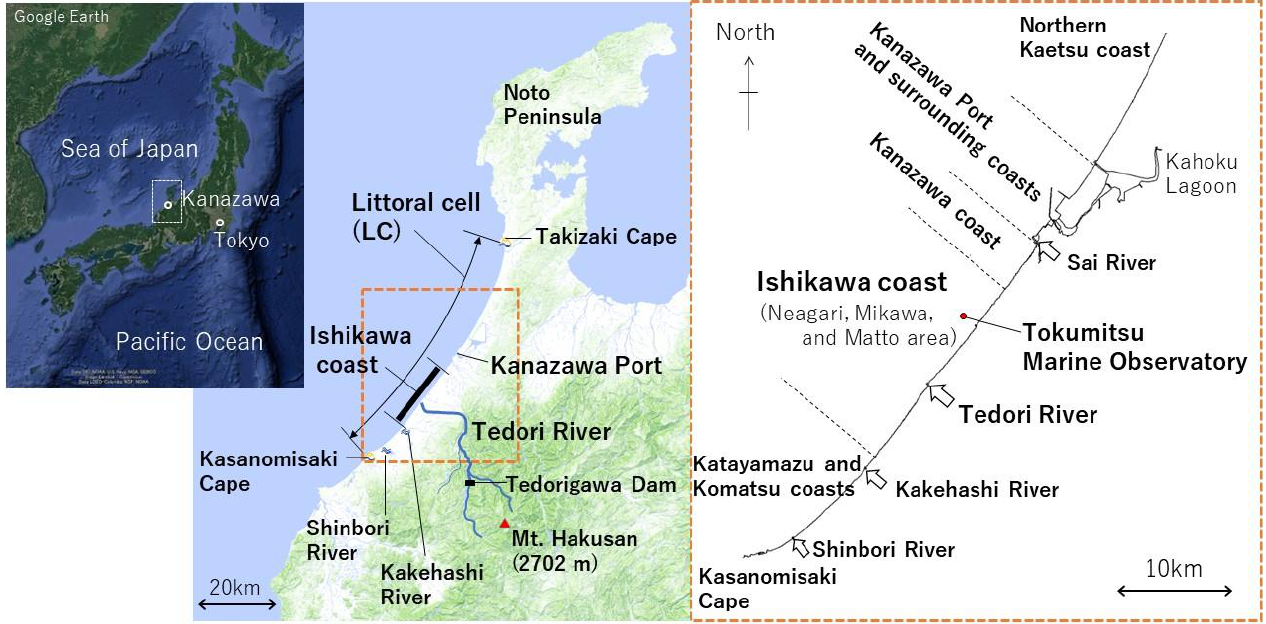
Figure 1. Locations of the Ishikawa coast, its surrounding coasts, and the Tedori River. The left aerial view depicts the position of the Ishikawa coast against a larger scale of Japan. The central diagram depicts the compartment shapes of study locations. The right diagram depicts the study details with the location of the Tokumitsu Marine Observatory.